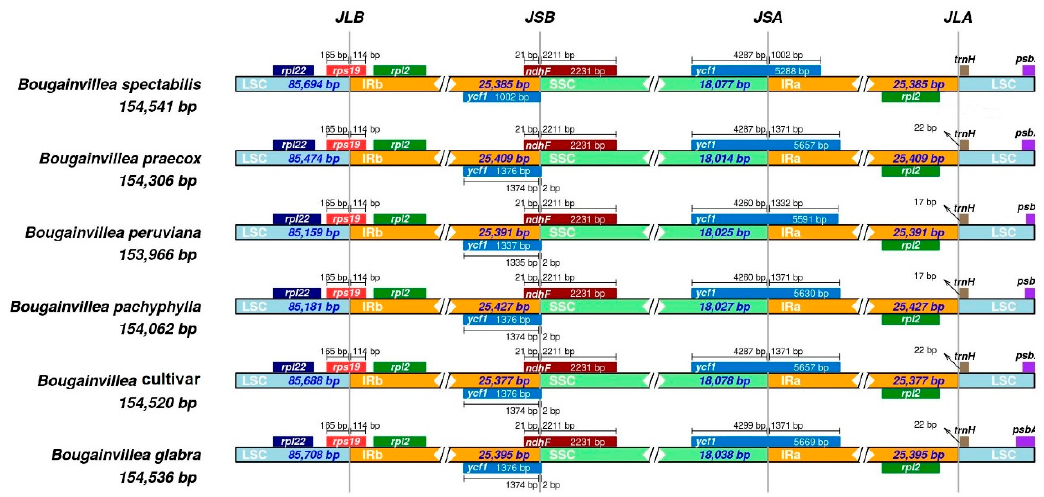
Figure 5. Comparisons of LSC, SSC, and IRs junctions among the six chloroplast genomes.